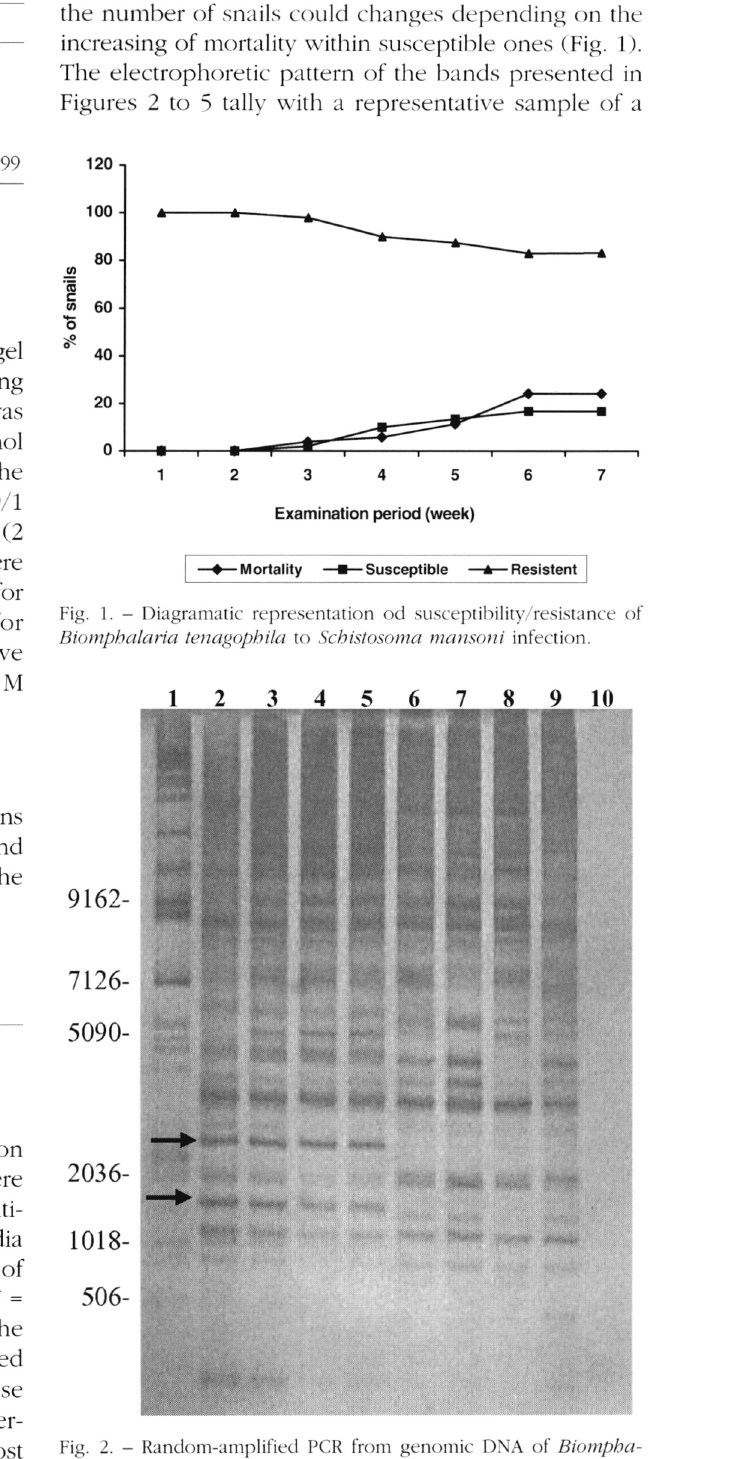
Fig. 2. - Random-amplified PCR from genomic DNA of Biompha- laria tenagophila strains resistant and susceptible using arbitrary primer 2 (5’-CTGATGCTAC-3’). Lane 1 (1-Kb DNA ladder); lane 2 (S1, susceptible); lane 3 (S2, susceptible); lane 4 (S3, susceptible); lane 5 (pool of S1, S2 and S3); lane 6 (pool of R1, R2 and R3); lane 7 (R1, resistant); lane 8 (R2, resistant); lane 9 (R3, resistant); lane 10 (negative control, amplification without DNA). Samples were analyzed electrophoresis through a 8 % polyacrylamide gel and visualized by silver staining. Polymorphic bands are indicated by